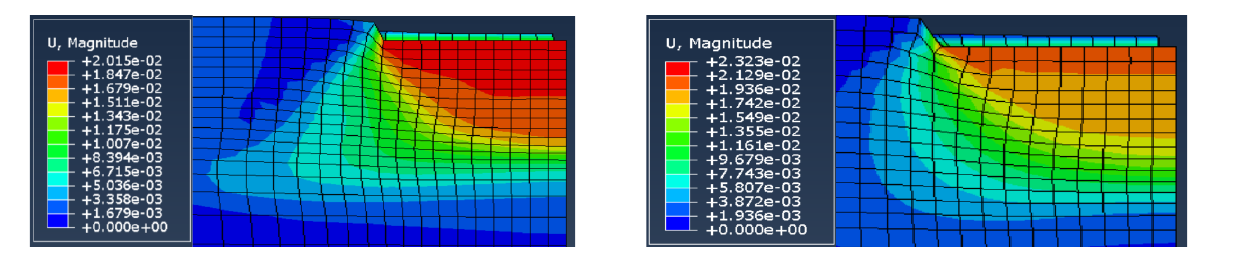
Figure 20 : Displacement contours of case 1 at h/B = 1.225 for L/B=2. Figure 21 : Displacement contours of case 8 at h/B = 1.225 for